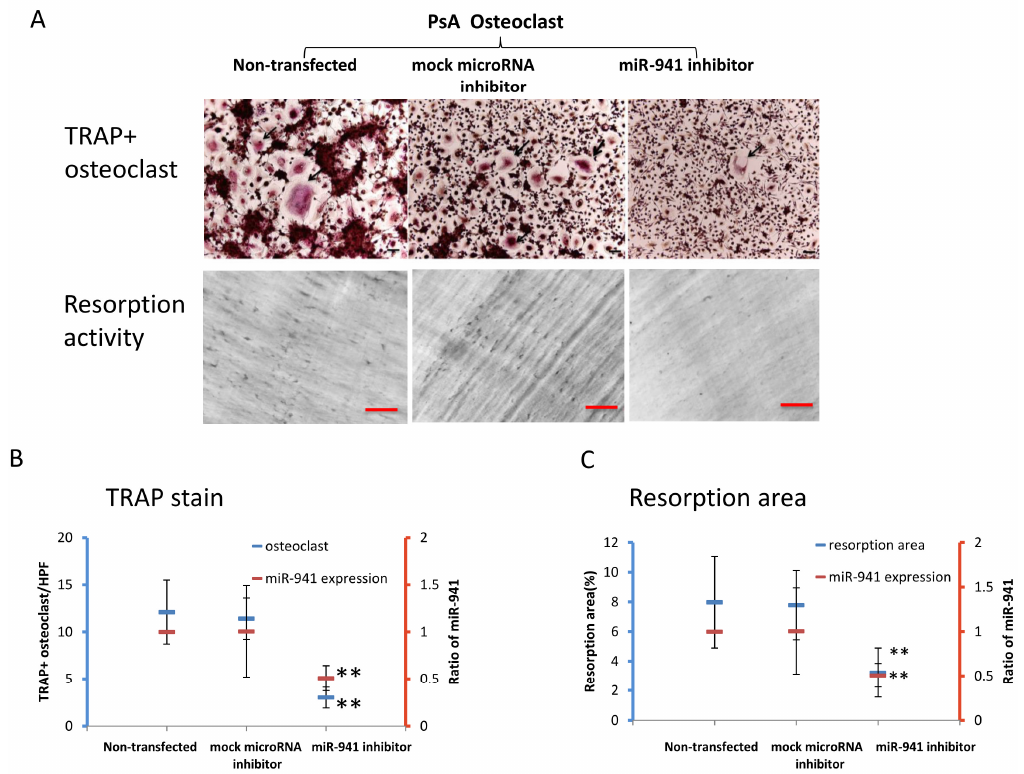
Figure 3. miR-941 inhibitor reversed osteoclast di ff erentiation and bone resorption activity in patients with PsA. The CD14 + monocytes were obtained from eight PsA patients and were subsequently activated into osteoclasts with treatment of M-CSF for 72 h. Cells were either nontransfected or transfected with the control-microRNA inhibitor or miR-941 inhibitor followed by TNF- α and RANKL very three days for nine days to study their ability to form osteoclasts and their activity of bone resorption. At day 13, the number of osteoclast formations and percentage of resorption pits were measured. ( A ) The cells were stained with TRAP to calculate the number of osteoclasts among non-transection, negative control miRNA and miR-941 inhibitor transfection groups, Scale bar: 50 µ m. For the evaluation of resorption activity, the resorption pits were recorded by a bright field microscope, Scale bar: 50 µ m. ( B ) The number of osteoclasts was quantified among the three groups (blue). The relative expression of miR-941, as standardized to the level of non-transfected osteoclasts, was depicted as orange color. ( C ) The eroded surface areas on the dentine slice were quantified using ImageJ software as percentage of expressions in total areas (blue line). The expressions of miR-941 in the osteoclasts were measured by qRT-PCR to evaluate the e ff ect of miR-941 inhibitors transfection. The relative expression of miR-941, as standardized to the level of non-transfected osteoclasts, was depicted as orange color. ** p <